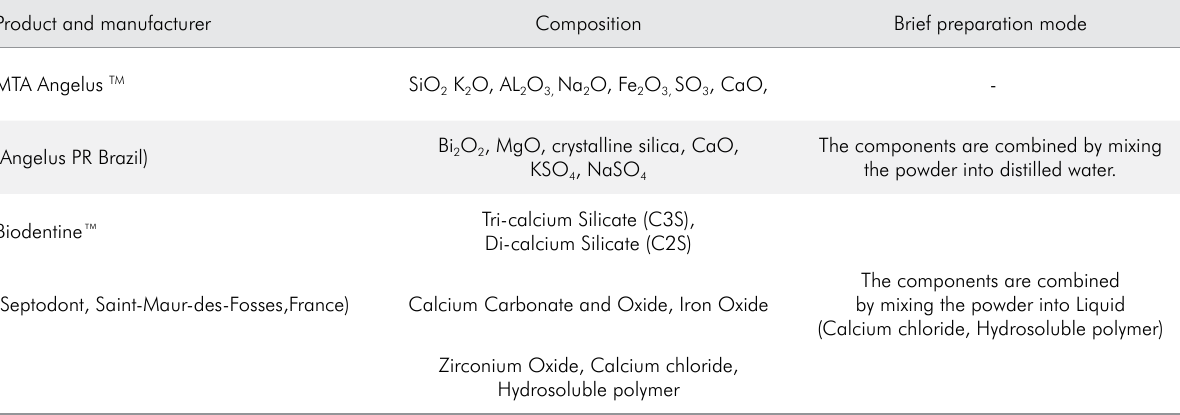
Table 1. Description of the tested materials, according to manufacturers. Product and